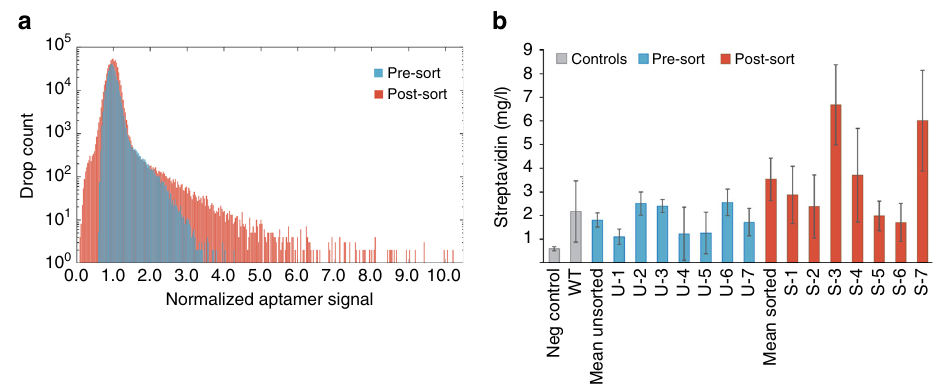
Fig. 4 RAPID screening for the improvement of streptavidin protein secretion through an evolved secretory tag. The RAPID screening approach was used to identify mutations in the α -mating factor ( α MF) secretory leader fused to streptavidin in yeast. a Histograms of droplet fl uorescence pre-sort and post- sort (re-encapsulated) demonstrate enrichment through the process. b Isolated and re-transformed clones randomly selected from the pre- and post-sort populations were quanti fi ed for streptavidin production. Error bars represent 95% con fi dence intervals of biological triplicates. Protein secretion from an individual clone was increased nearly threefold over wild-type production using this approach, and there was also twofold increase in secretion between the mean of the sorted and